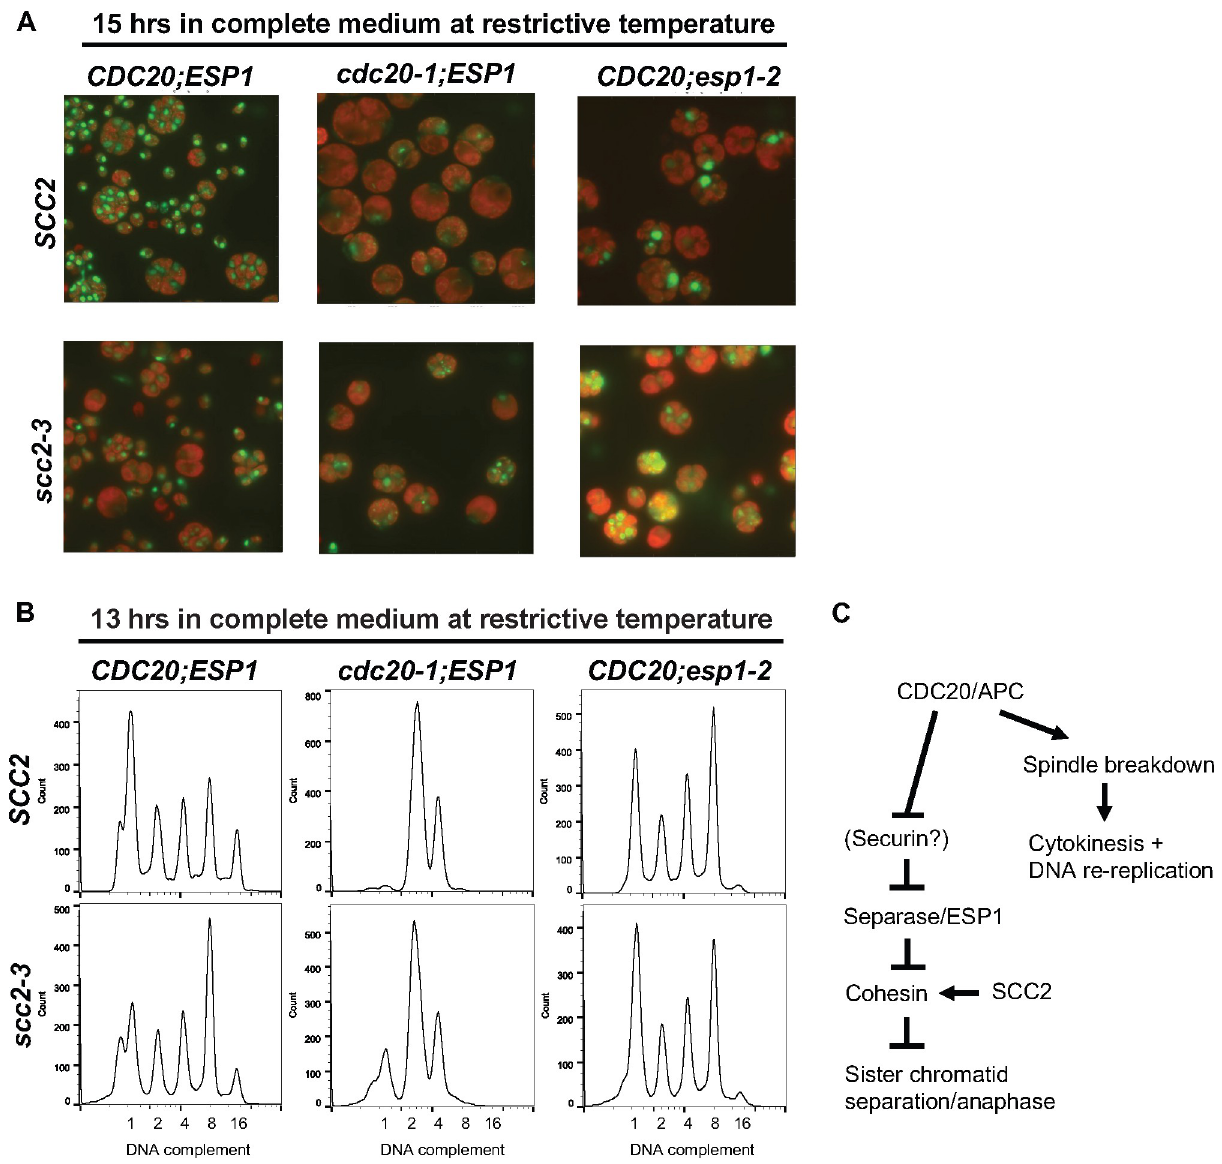
Fig 4. DNA localization and replication in APC ( cdc20 ) and separase ( esp1 ) mutants. (A) Wild-type, cdc20-1 , esp1-2 mutants with or without scc2-3 were blocked in G1 by nitrogen deprivation, as described [29], then placed at restrictive temperature (33˚C) in complete medium, collected after 15 hrs., and stained with Syto11 live cell green fluorescent nucleic acid stain. Red signal is from chloroplast auto-fluorescence. (B) Flow cytometry from same set of cells as (A) but after a collection at 13 hrs. For flow cytometry data from 0 and 15h, as well as corresponding cell size data, see S4A Fig. (C) Proposed model for the regulation of both DNA replication and sister chromatid separation by